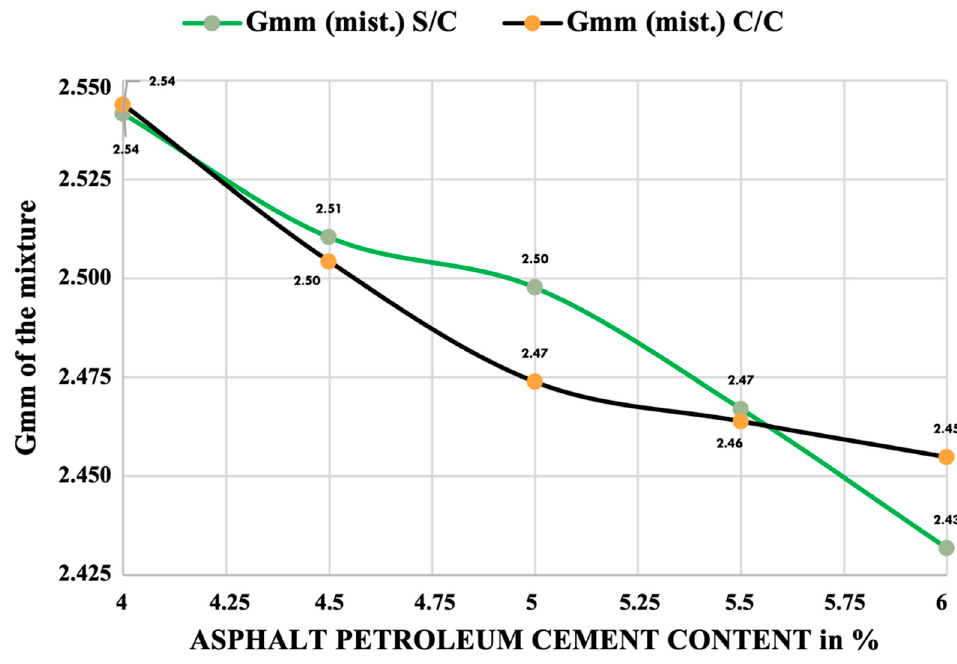
Figure 3. Maximum Specific Mass Measured (Gmm).